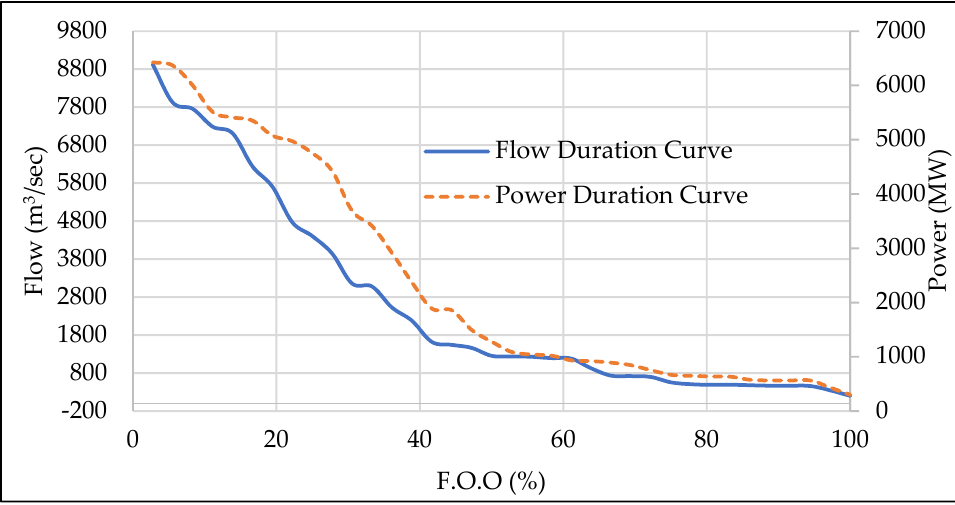
Figure 41. Flow and Power Duration curves of Application year 2035.